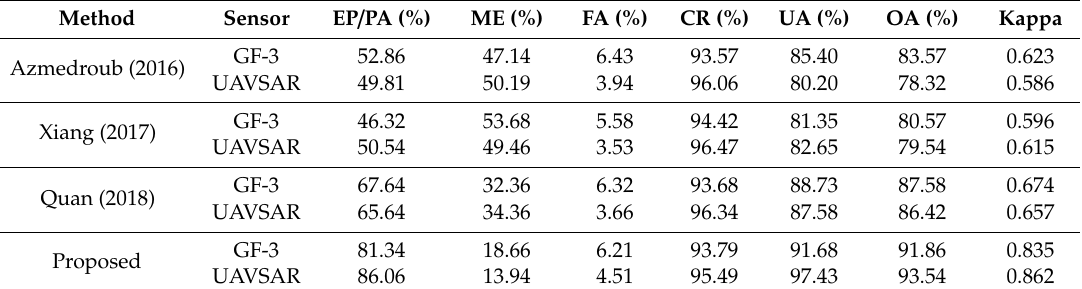
Table 5. Accuracy of extracted buildings from di ff erent